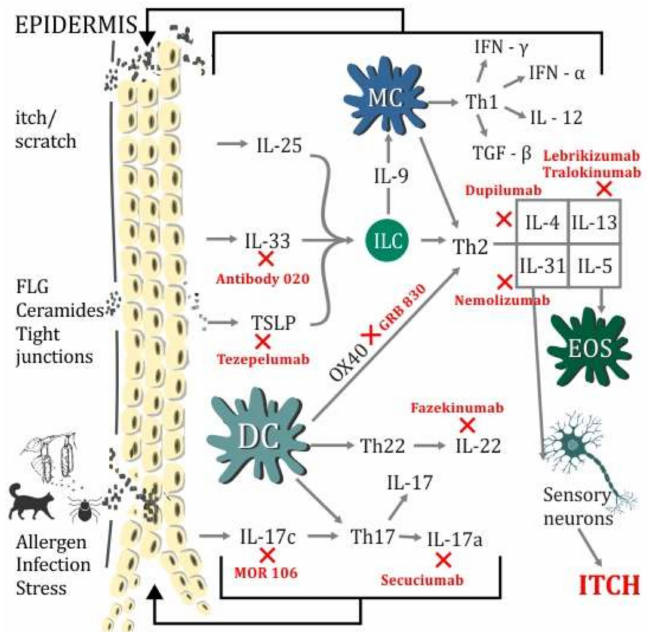
Figure 1. Schematic summary of immunological disorders in Atopic dermatitis (AD) pathogenesis coexisting with skin barrier defect. The diagram shows inflammatory cells, Th2, Th17, and Th22-dependent inflammation in AD with cytokines, which diminish the epidermal barrier. The impact of infections, allergens, stress, and itchiness, leading to the activation of inflammatory pathways. The figure depicts the possible targets of biological agents in AD treatment. DC (dendritic cells), EOS (eosinophil), FLG (filaggrin), IL (interleukin), IFN- α (interferon-alfa), IFN- γ (interferon gamma), ILC (lymphoid cells), MC (mast cells), TGF- β (transforming growth factor beta), TSLP (thymic stromal lymphopoietin). X—indicates potential areas of new biological drugs